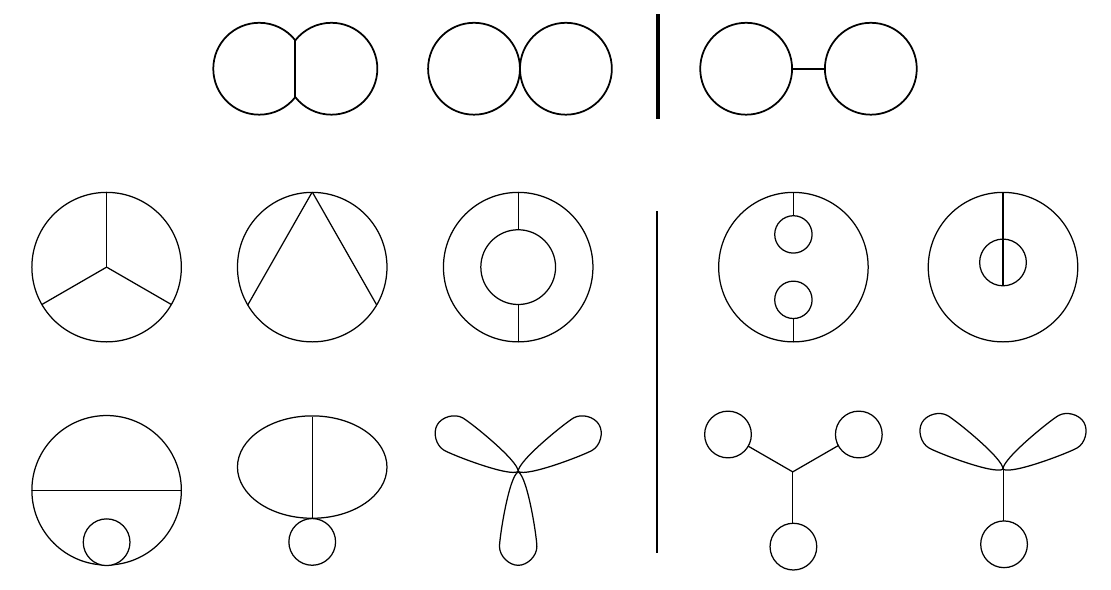
Figure 11 . Examples of the connected metric ribbon graphs with ( g; n ) = (0 ; 3) (above) and (0 ; 4) (below). The diagrams on the right half have self-edges, and some diagrams on the left half are